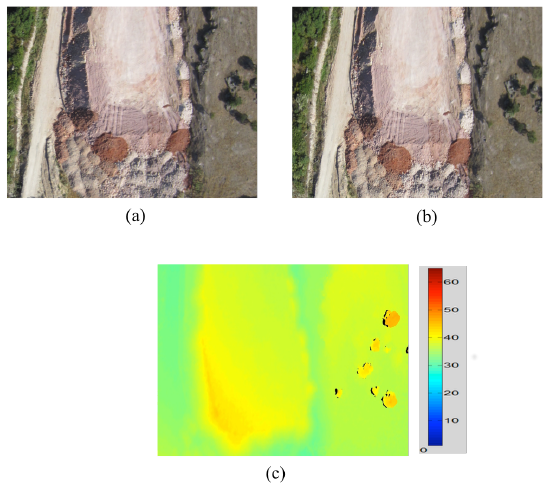
Figure 3. First (a) and second (b) image of the area of interest, and disparity map (c) -lower values tend to dark blue, higher values to dark red and occlusions are depicted in black